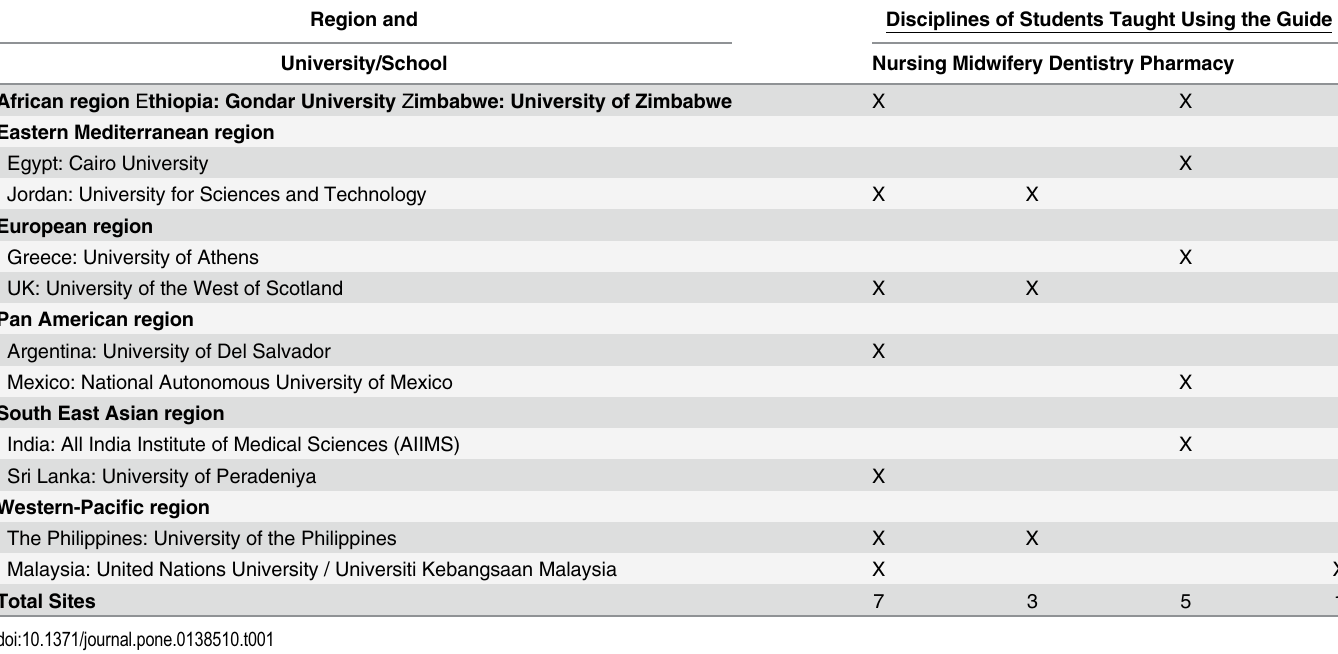
Table 1. Universities/Schools that participated in the Curriculum Guide field test and evaluation. Region